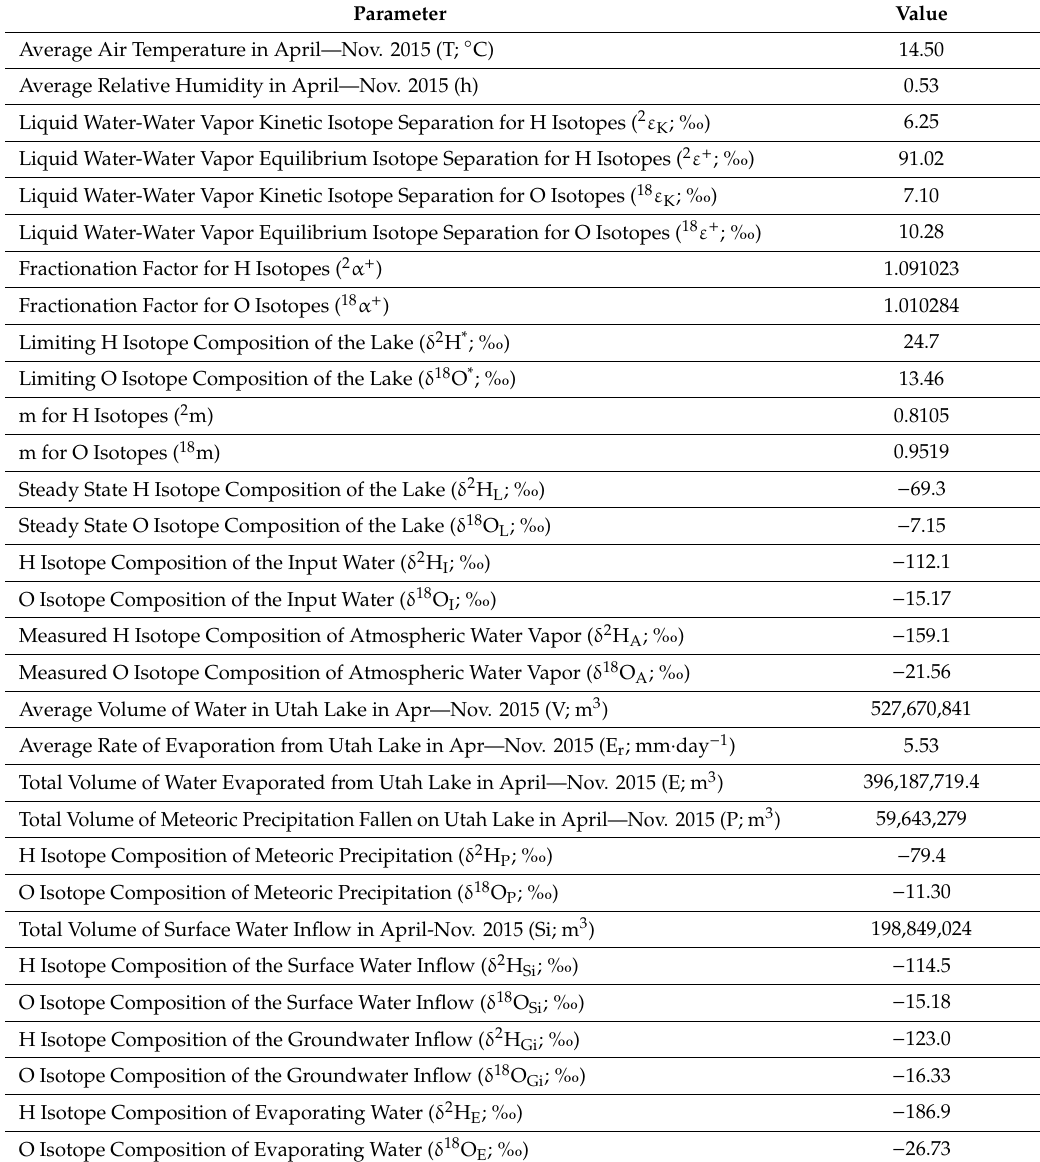
Table 3. Input parameters used to calculate the throughflow index, the residence time of water, and the rate of groundwater inflow for Utah Lake using the equations of [34] and of [20]. See text for details. Parameter Value Average Air Temperature in April—Nov. 2015 (T; ◦ C)